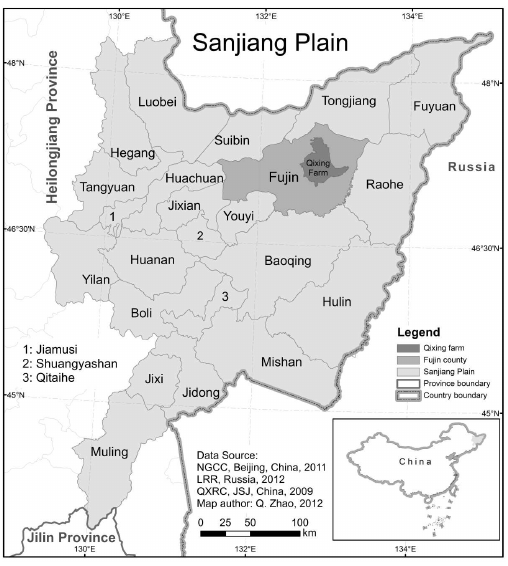
Figure 1. Location and counties of the SJP